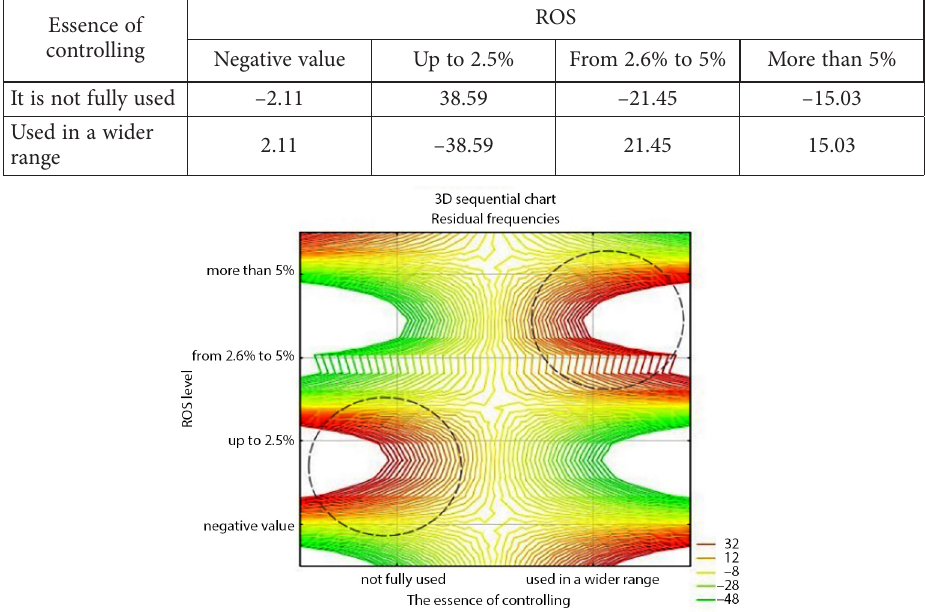
Table 9. Contingency table – residual frequencies for various combinations of essence of controlling and the level of ROS